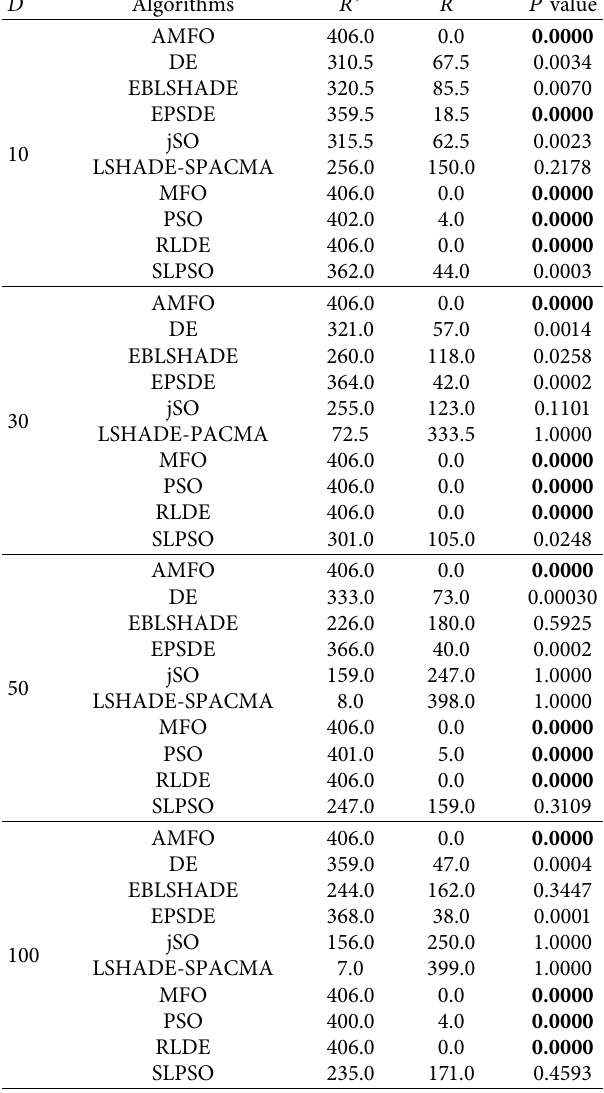
Table 3: Wilcoxon’s test between ASDE and other algorithms for D � 10, 30, 50, and 100 using